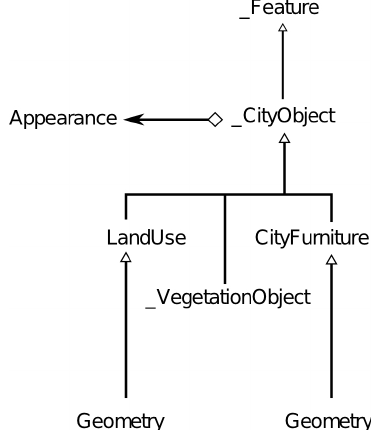
Figure 2: An overview of the CityGML hierarchy. Every ob- ject stored in CityGML has a geometry (described in the Spatial Model), an appearance i.e. surface properties (described in the Appearance Model) and is of certain type (described in the The- matic